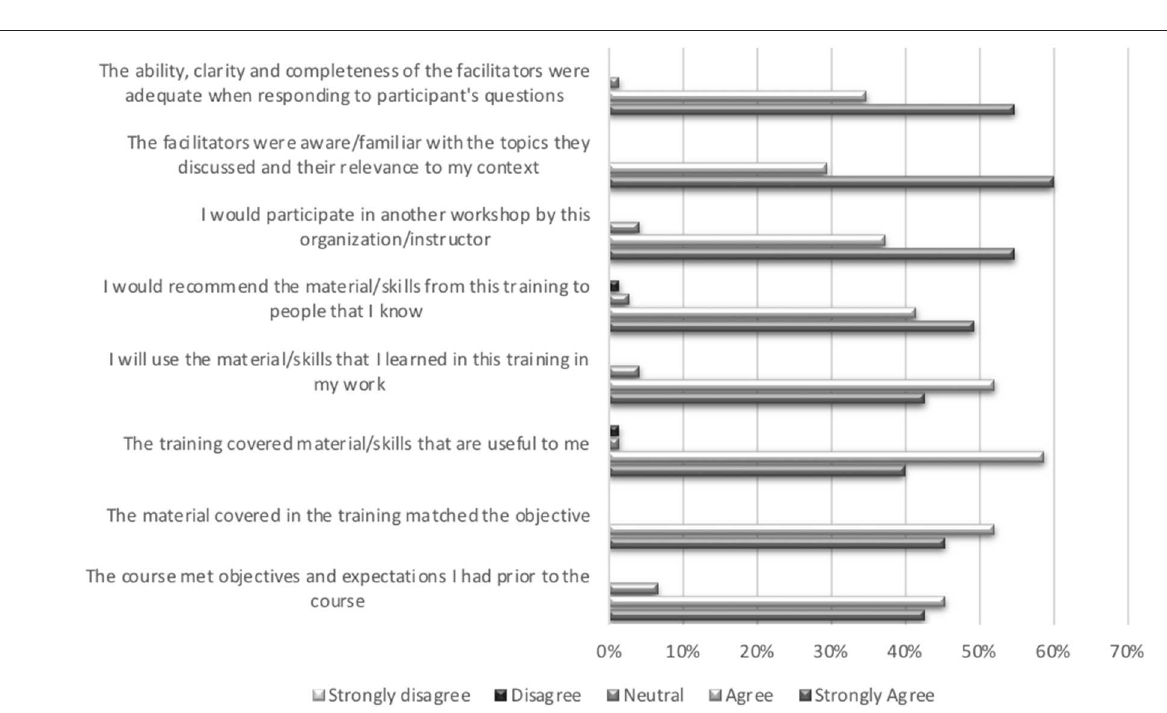
Frontiers in Public Health |